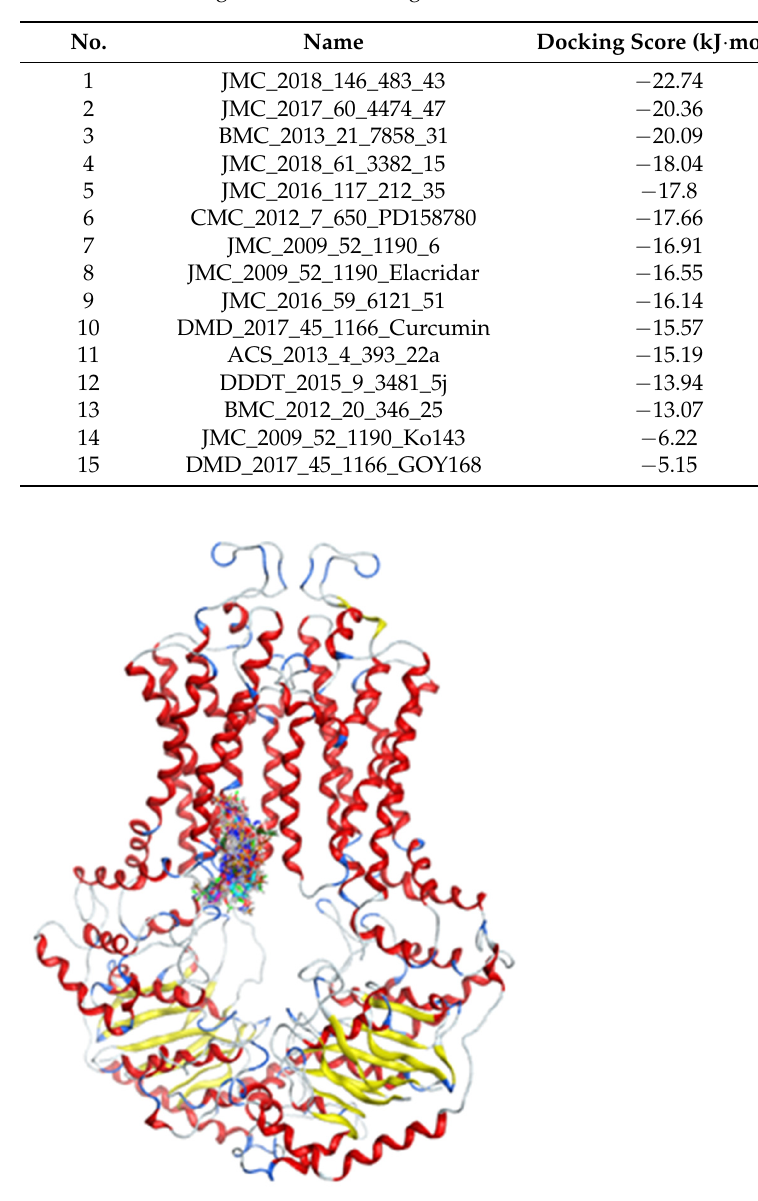
Table 5. The docking results of 15 strong inhibitors.